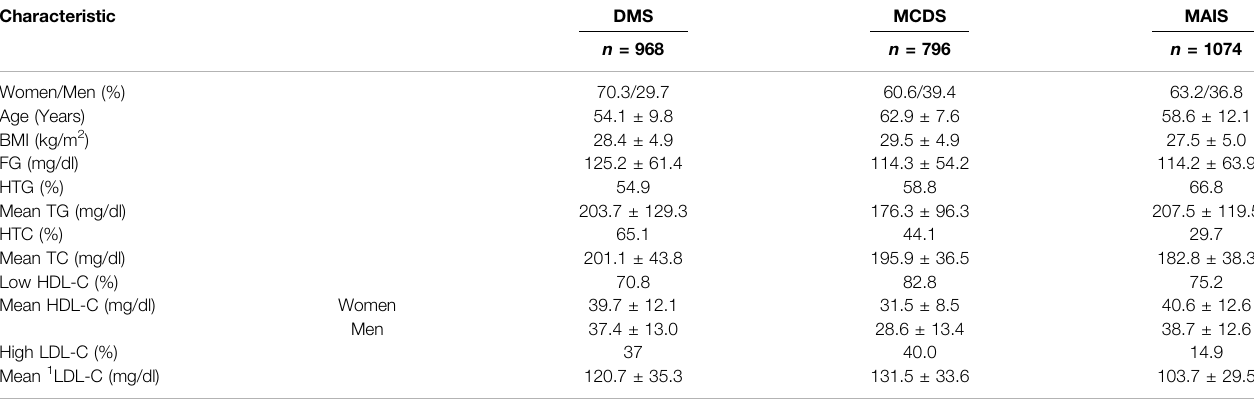
TABLE 1 | Clinical and demographic characteristics of the studied